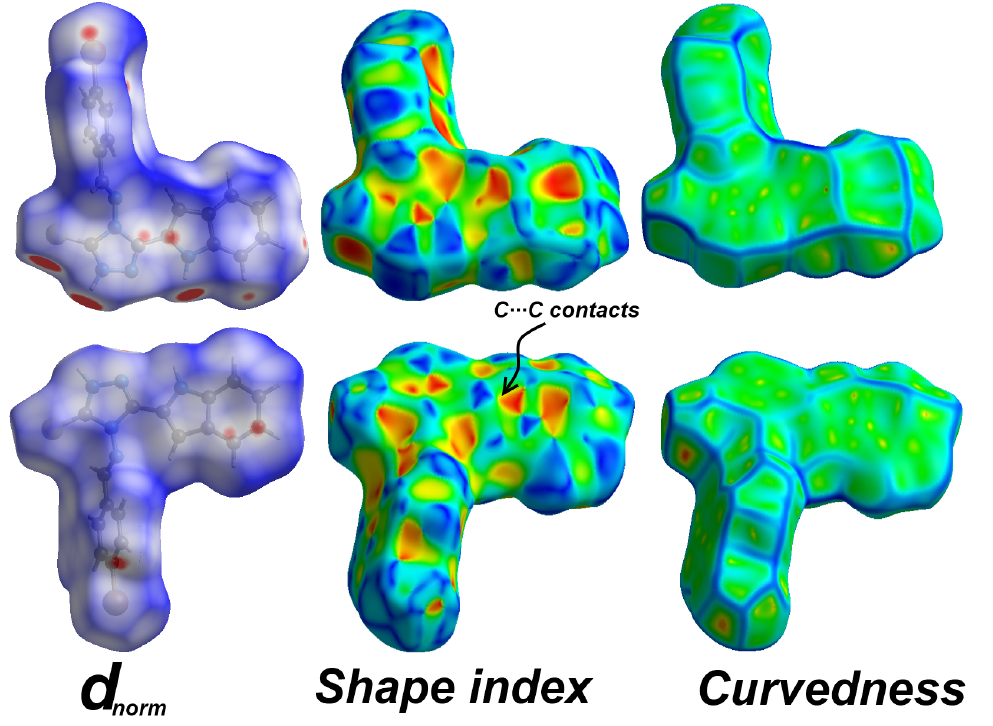
Figure 4. Hirshfeld surfaces of 3 .